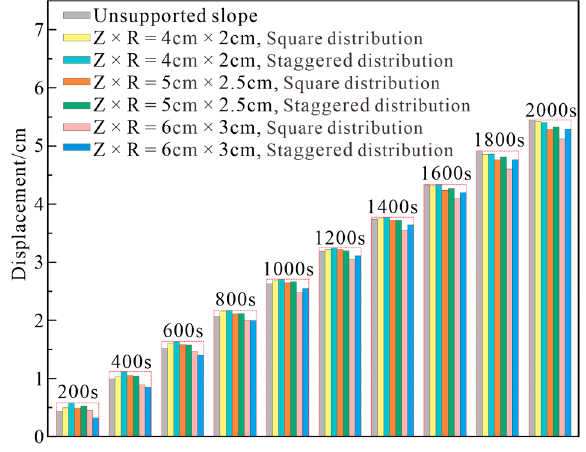
Figure 11. Effect of volume and planting pattern of tap-like root system on slope surface displacement with constant plant spacing.